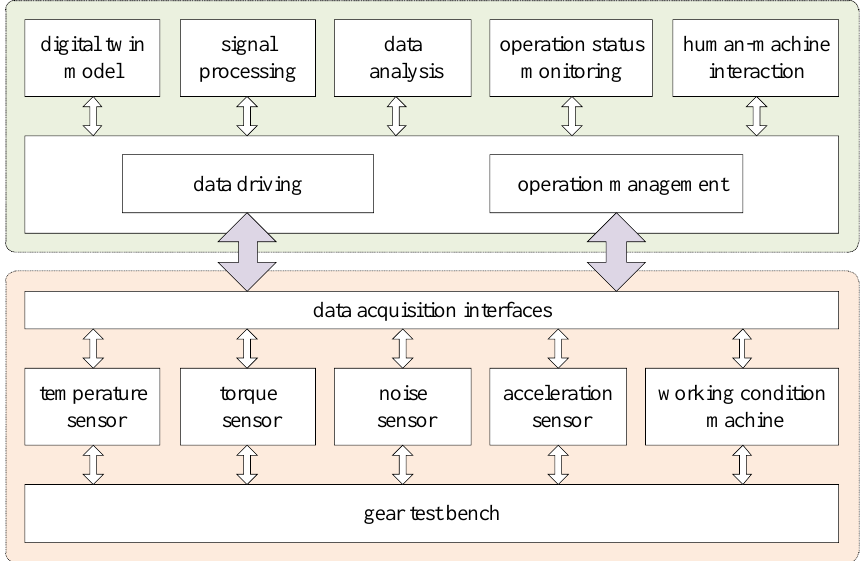
Figure 1. State monitoring system of the gear test bench based on a digital twin model.